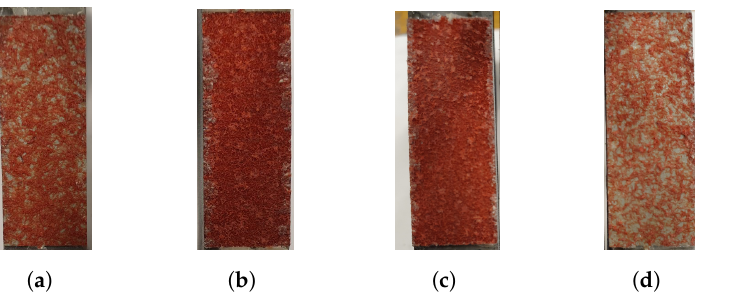
Figure 18. The fractured cores of two specimens, subjected to LC 4, are presented. ( a , c ) contain the lower skins and ( b , d ) contain the upper